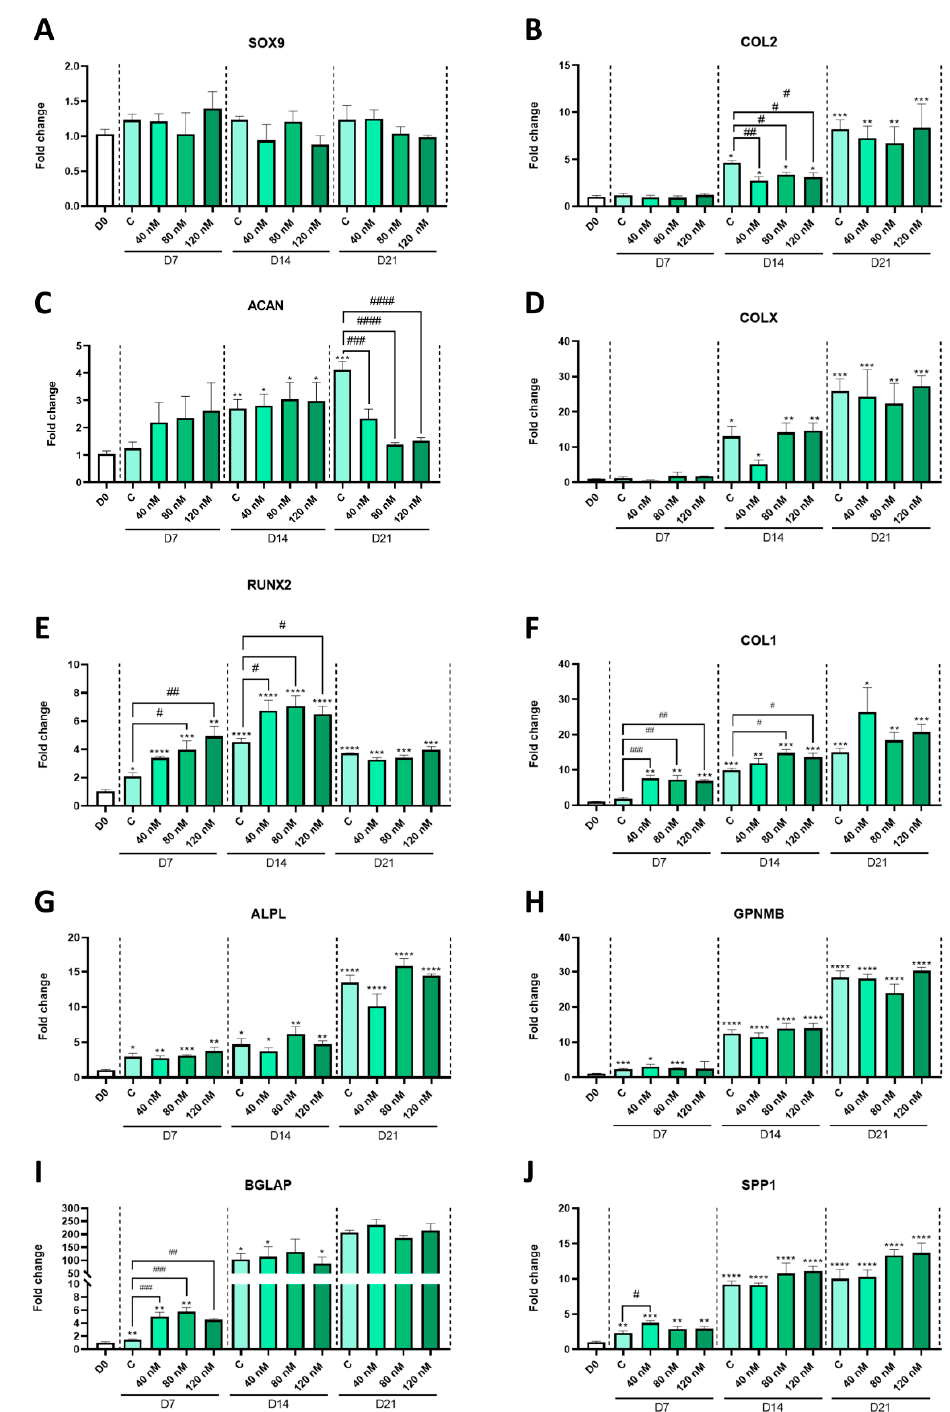
Figure 2. Relative expression levels of chondrocyte ( A – D ) and osteoblast ( E – J ) markers in ATDC5 cells throughout the 21 days of differentiation with or without MPH (40, 80, and 120 nM). SOX9: SRY-box transcription factor 9; COL2: type II collagen; ACAN: aggrecan; RUNX2: Runt-related transcription factor 2; COL1: type I collagen; ALPL: alkaline phosphatase; GPNMB: osteoactivin; BGLAP: osteocalcin; SPP1: osteopontin. Bars represent means with SEM (n = 3). *: statistically different vs. day 0 ( p < 0.05); **: p < 0.01; ***: p < 0.001; ****: p < 0.0001; #: statistically different vs. untreated control from the same day ( p < 0.05); ##: p < 0.01; ###: p < 0.001; ####: p <